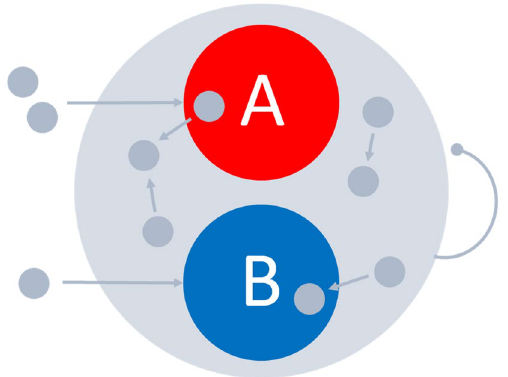
Figure 2. Network architecture of the decision system: the recurrent network of the excitatory neurons has a higher density of connections in neuronal pools A and B. Neuronal pools A and B form the decision sets and are selective to inputs. Inputs are provided by separate pools of neurons (outside of the decision system) projecting to A and B, respectively. The system is equipped with a global inhibition mechanism that facilitates winner-take- all competition.